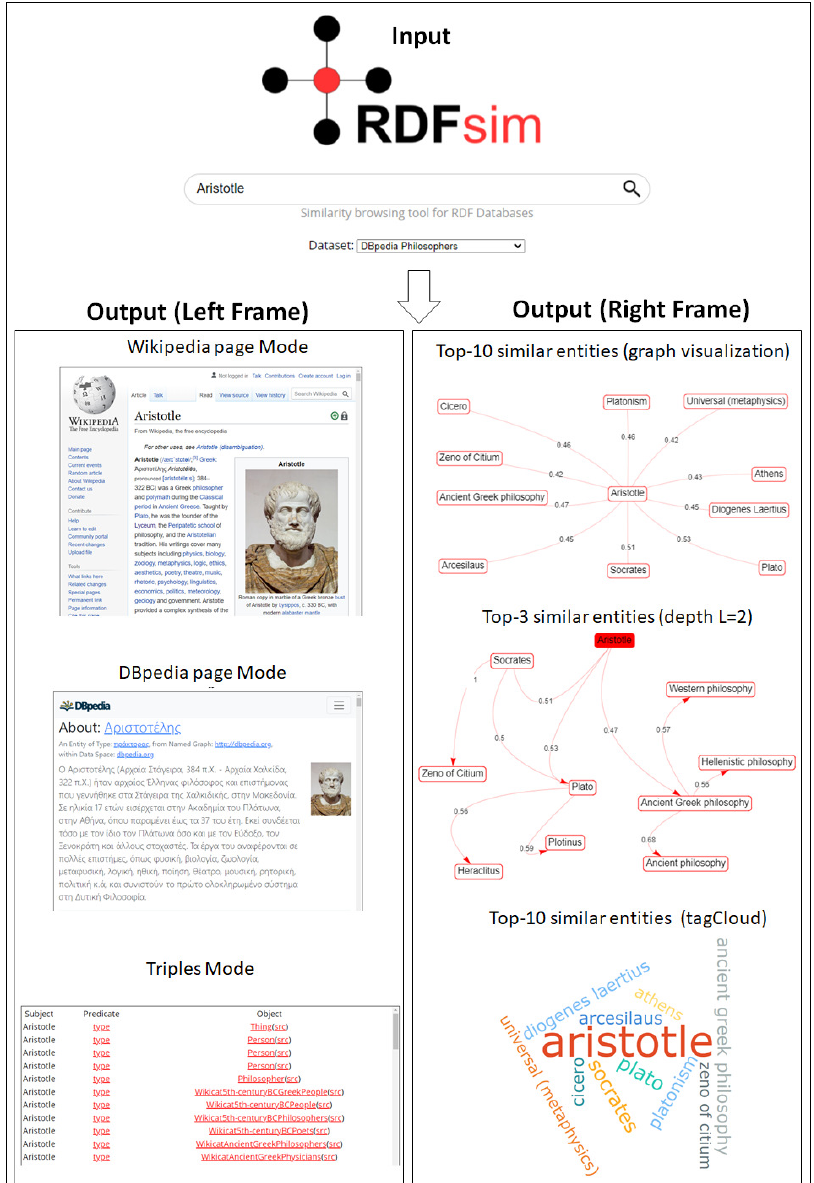
Figure 5. Parallel Browsing for the selected entity